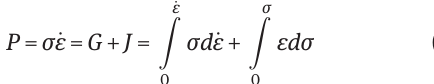
Table 7: Statistical parameters for KHL